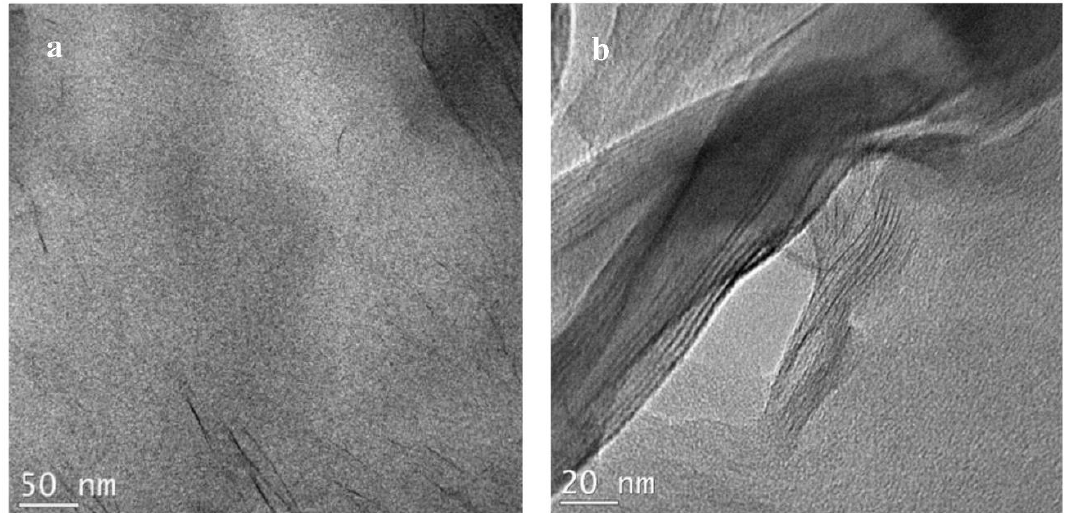
Figure 12. TEM micrographs for N6-15A prepared by static melt annealing showing some individual silicate layers ( a ) and intercalated particles ( b ).